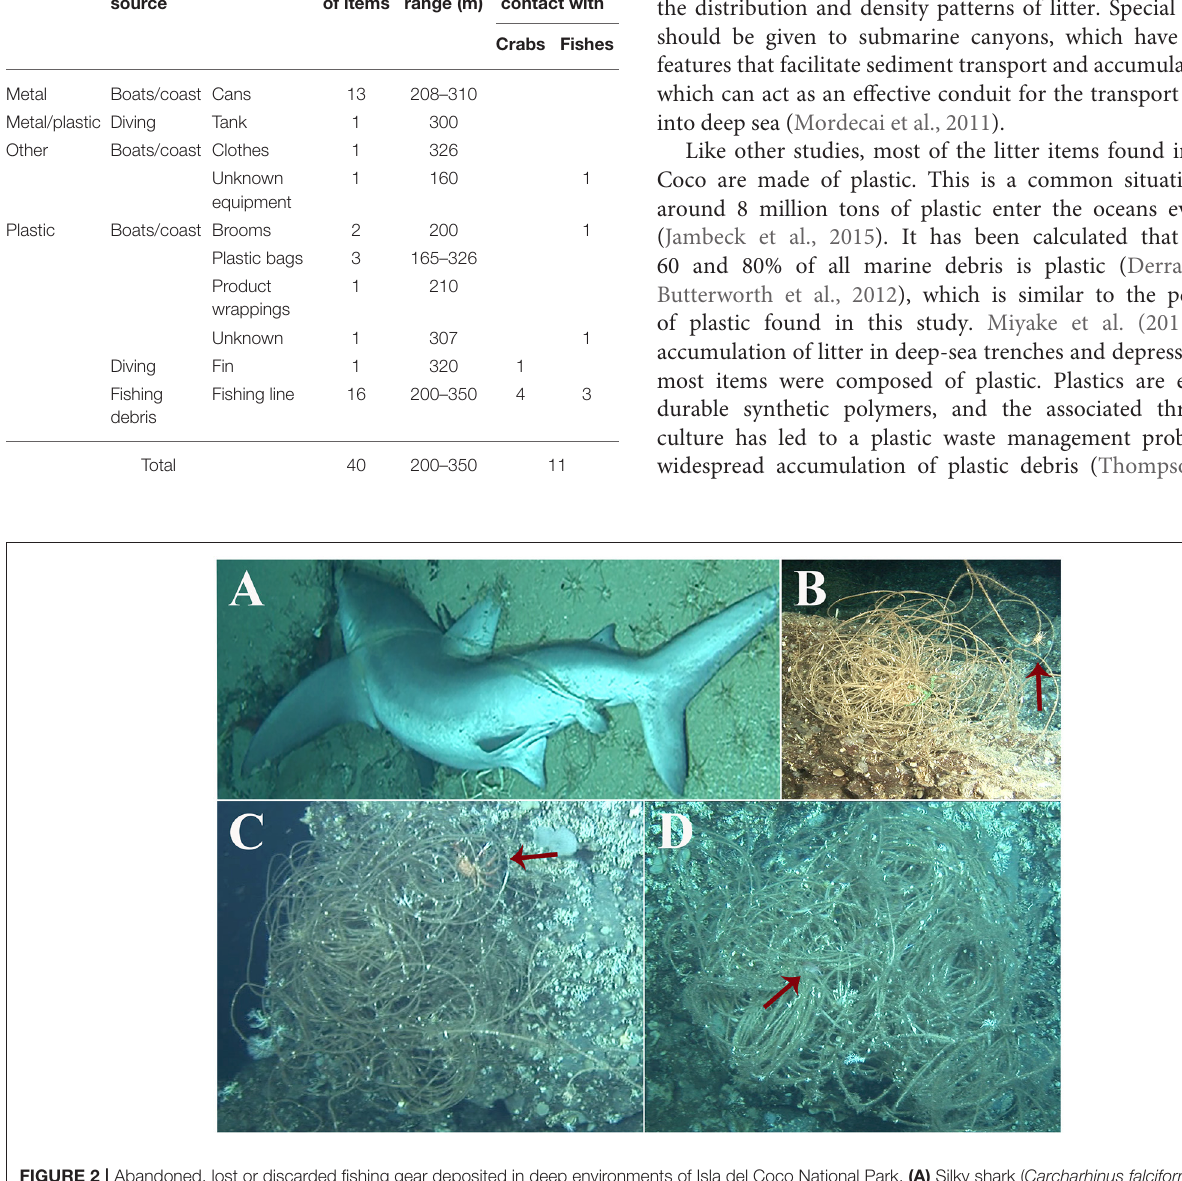
Frontiers in Marine Science |